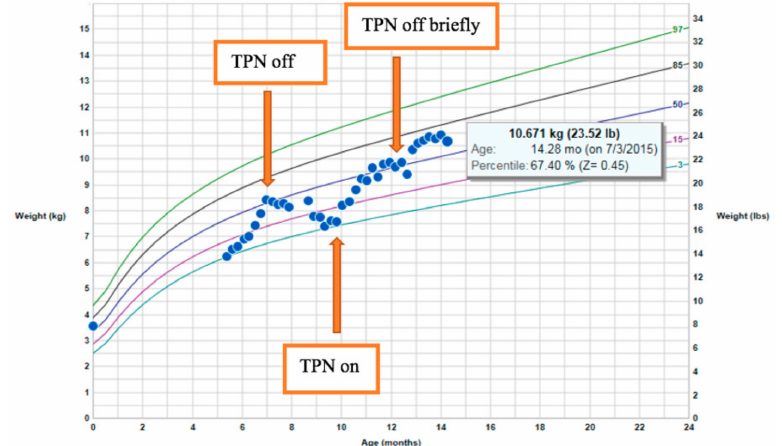
Figure 1. Rapid weight gain on limited total parenteral nutrition (TPN)